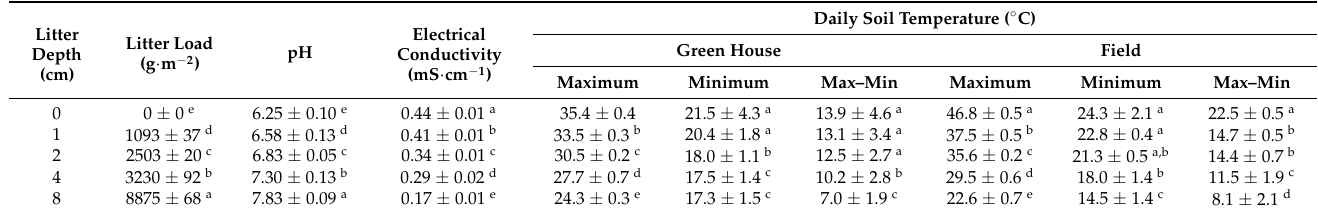
Table 2. Litter load (g m − 2 ), soil pH, electrical conductivity (mS · cm − 1 ), maximum and minimum soil temperature ( ◦ C), and range of soil temperatures (maximum–minimum temperatures) ( ◦ C) ( n = 3) for the five Prosopis juliflora leaf litter depth treatments. Different letters indicate significant differences between treatments (ANOVA, p <